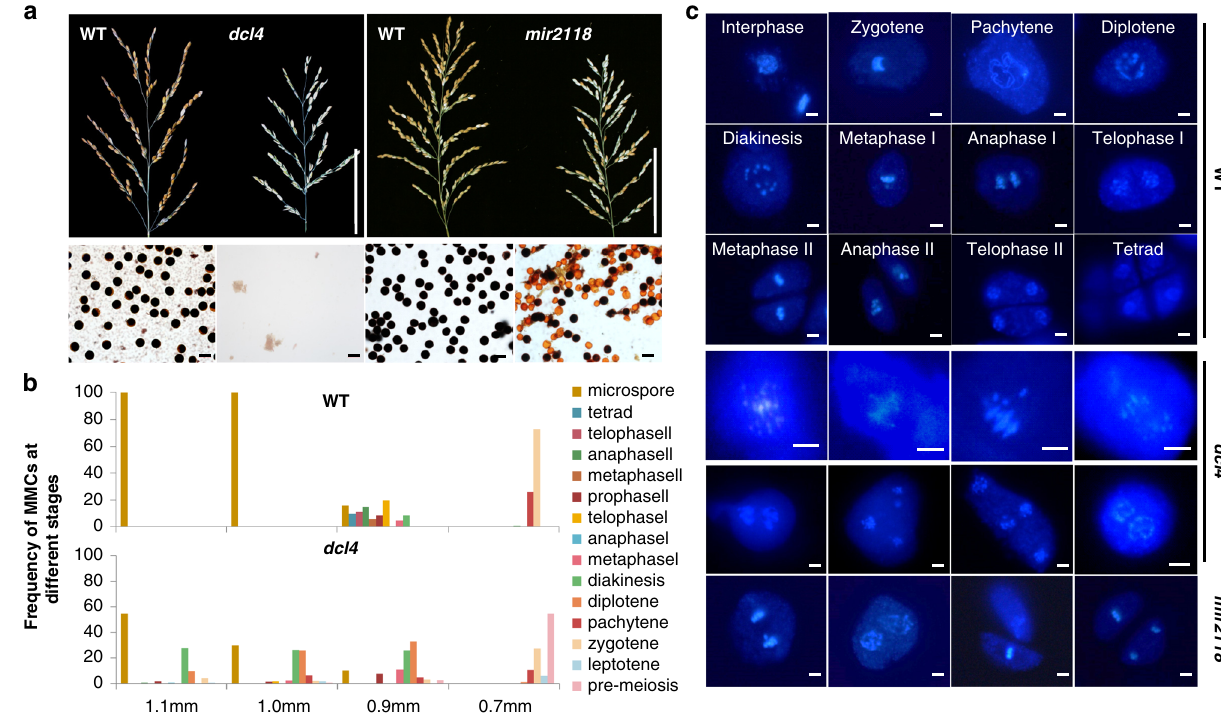
Fig. 4 PhasiRNAs are required for meiosis progression. a Panicles and pollen grains (stained with iodine-potassium iodide) of dcl4 , mir2118 , and wild-type (WT) plants. Scale bars = 10 cm for panicles and 100 µ m for pollen grains. n = 4 independent replicates. b Frequency of PMCs at various meiotic stages in anthers ranging from 0.7 to 1.1 mm in length. 84 – 373 pollen mother cells were accessed from approximately 30 – 40 anthers for each anther size class, and these were collected from fi ve dcl4 transgenic plants and ten WT plants. c The meiosis processes by staining with 4 ʹ ,6-diamidino-2-phenylindole (DAPI) of WT, dcl4 , and mir2118 PMCs. Scale bars = 4 µ m. n = 5 independent